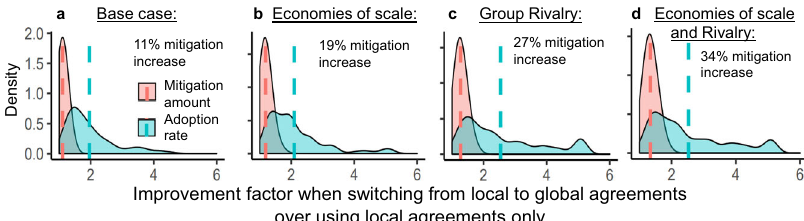
Fig. 2 The bene fi t of shifting from local to global agreements increases with economies of scale and group rivalry. Panels show the factor by which shifting outperforms local-only approaches (i.e., 2 = 200% increase) in mitigation adoption rate (time until 80% of players mitigate, teal) and total amount of mitigation achieved (by time step 625, red) in simulations of a the base model, b the model with economies of scale, c the model with group rivalry, and d both economies of scale and rivalry. Distributions give relative improvements in rates and total mitigation found within each of 100 replicate model runs, and vertical dashed lines denote mean improvement in each metric. Note that shifting outperformed local-only strategies in all cases (i.e., all values > 1). Shift from local to global negotiations happens at T = 0.4; all other parameters values listed in Supplementary Fig.